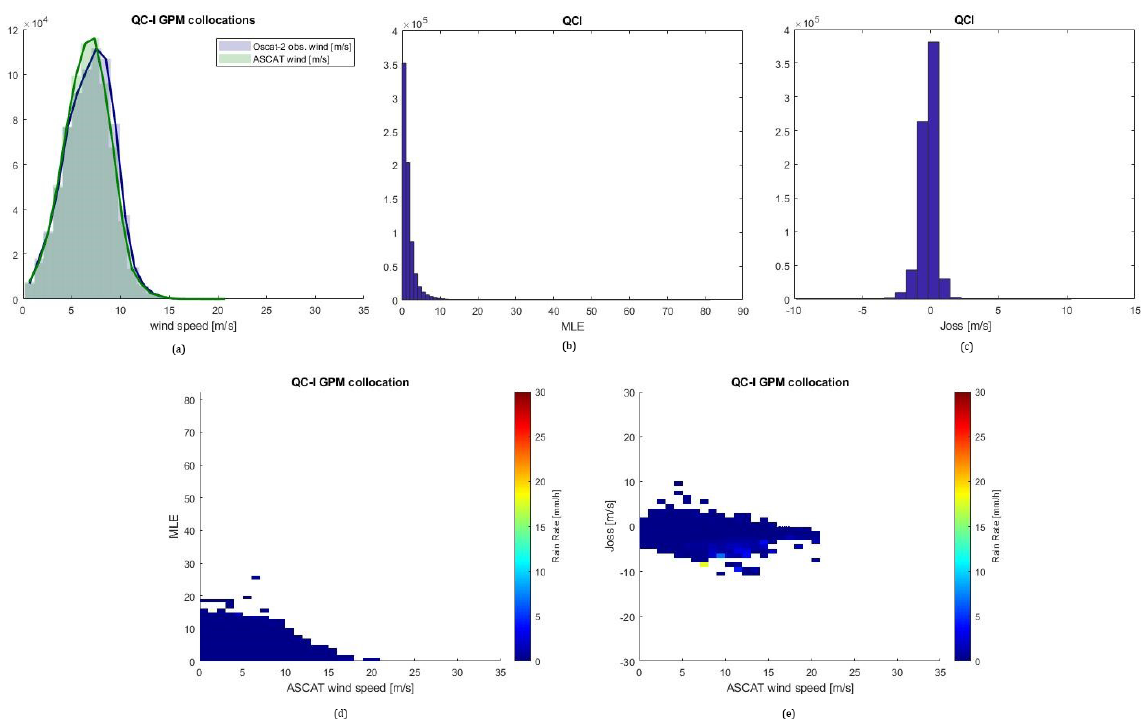
Figure 1. Collocated wind speed distributions in the QC-I set (a) , corresponding MLE distribution of OSCAT-2 (b) , Joss (c) , collocated rain rates with reference to MLE (d) and Joss (e) .